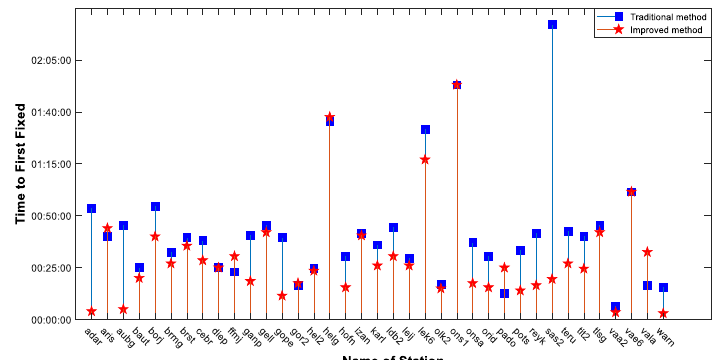
Figure 15. TTFF of 37 stations in the dynamic model.